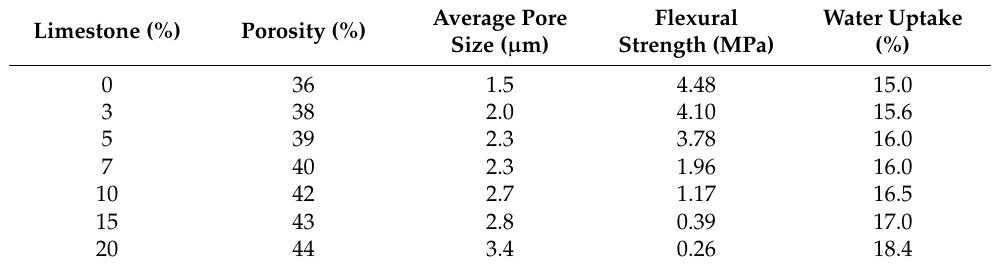
Table 4. Porosity, pore size, flexural strength and water uptake of the various membranes. Limestone (%) Porosity (%)